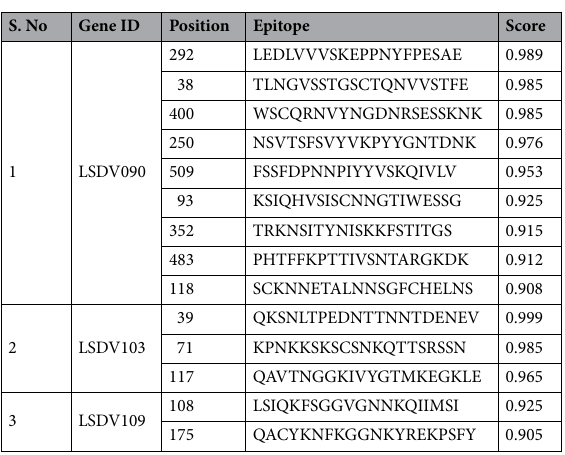
Table 2. Predicted B-cell epitopes from the selected proteins of LSDV.